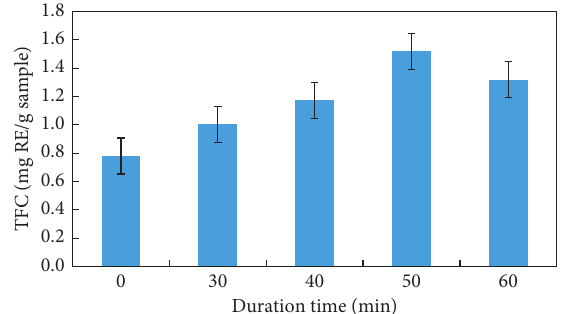
Figure 2: Effects of sonication time on the recovery of total fla- vonoid